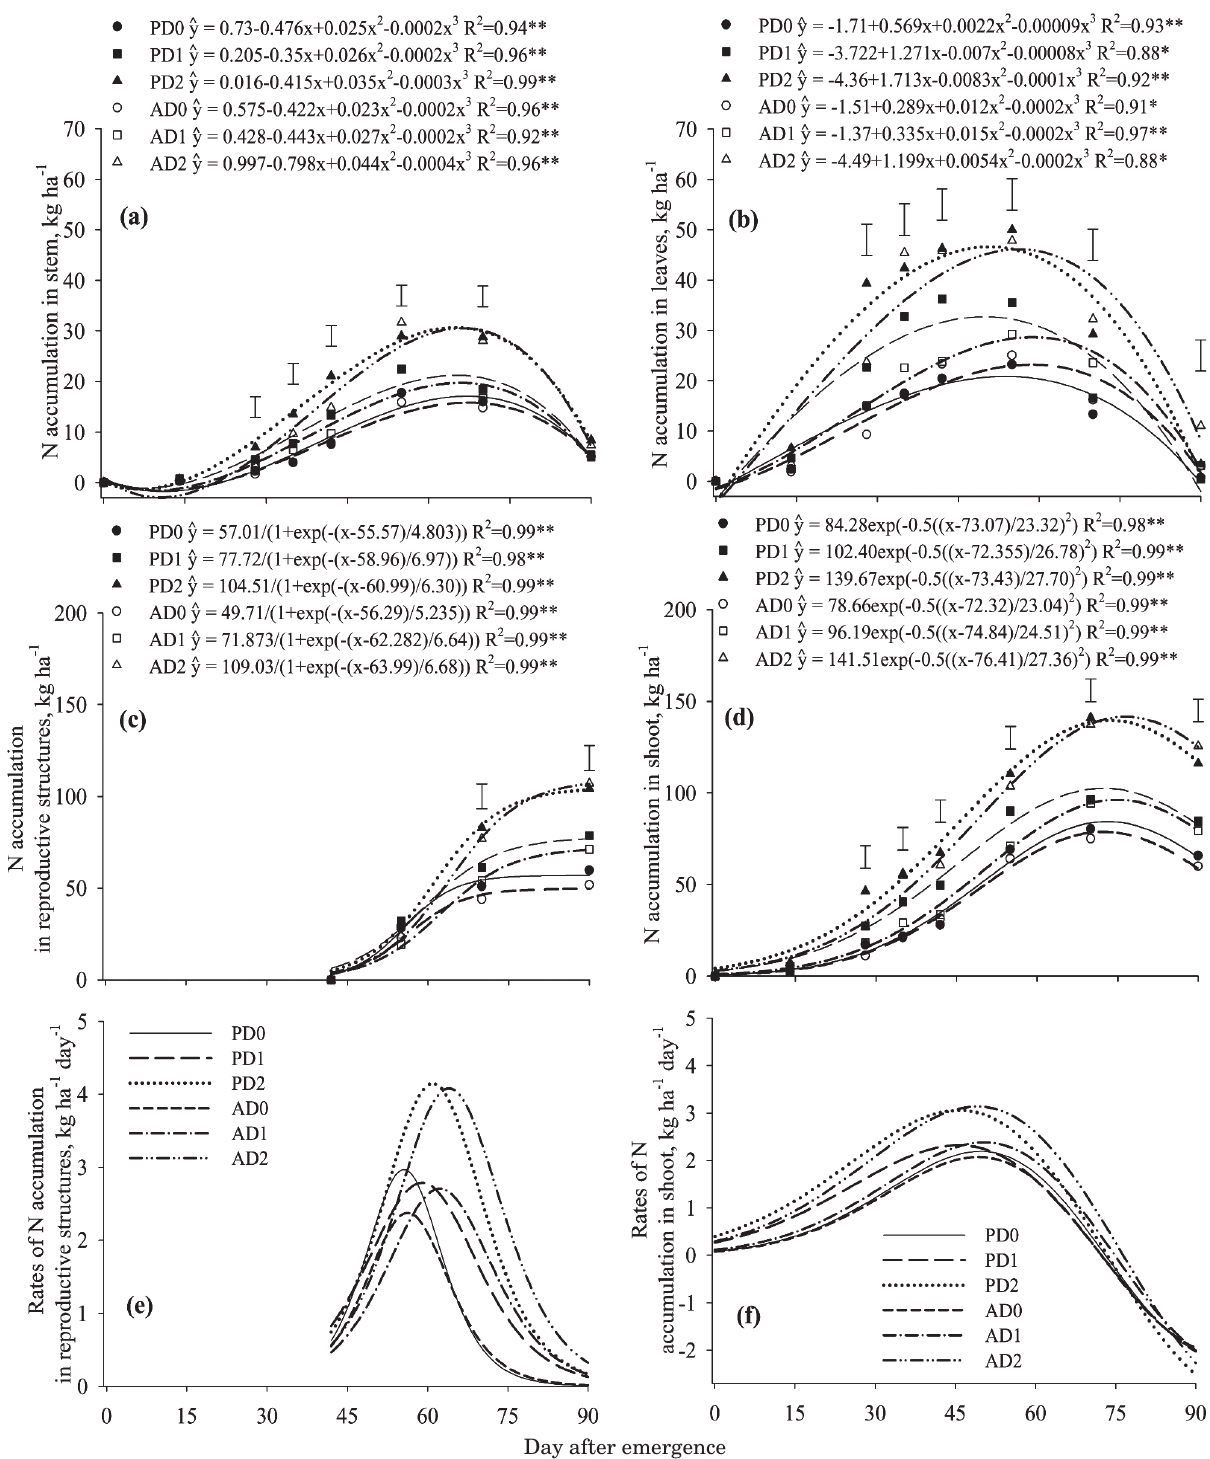
Figure 2. Nitrogen accumulation in stem (a), leaves (b), reproductive structures (c), and shoot (d) and rates of accumulation of N in reproductive structures (e) and shoot (f) of common bean cultivars, under different levels of fertilization. ** and * are: significant at p 0.01 and p 0.05 by the F test. Vertical bars represent the Least Significant Difference (LSD) at p 0.05. PD0 = Pérola without NPK fertilization, PD1 = Pérola with 50 % of recommended NPK fertilization; PD2 = Pérola with 100 % of recommended NPK fertilization; AD0 = IAC Alvorada without NPK fertilization, AD1 = IAC Alvorada with 50 % of recommended NPK fertilization; AD2 = IAC Alvorada with 100 % of recommended NPK